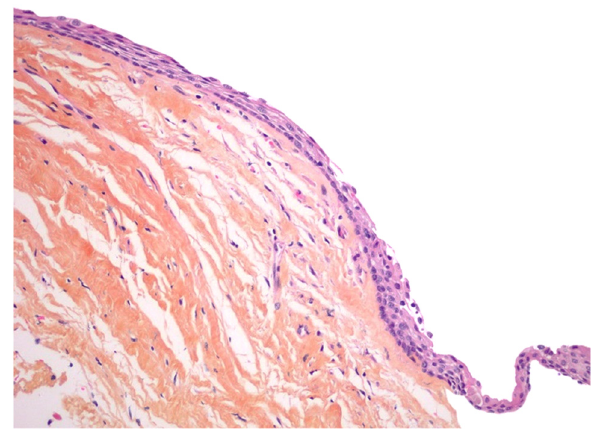
Figure 4. Histopathological aspect of the cyst.